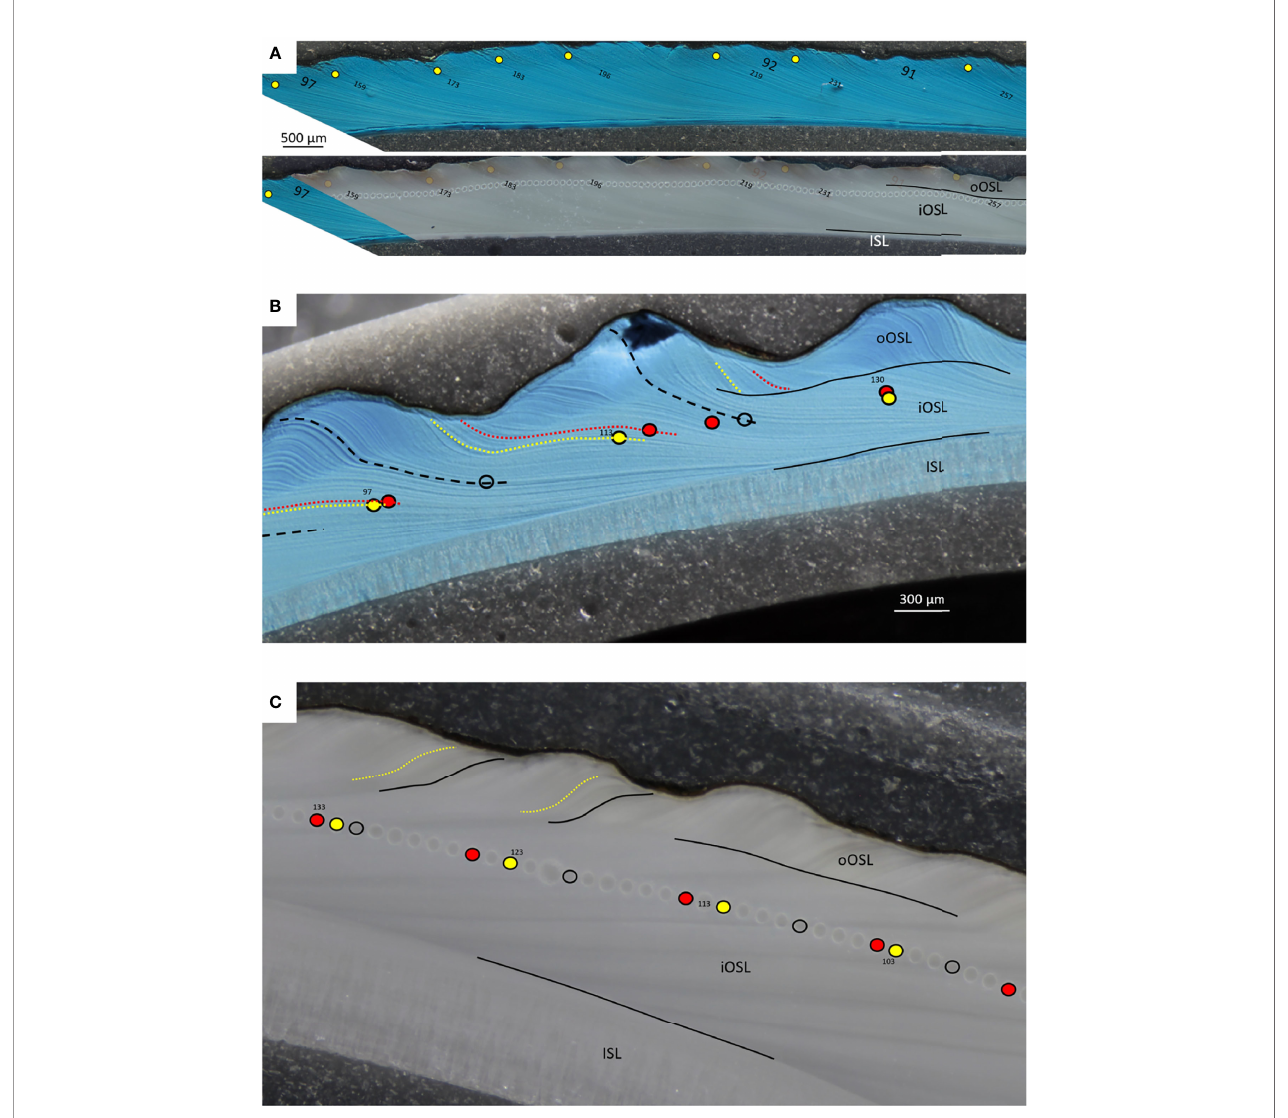
FIGURE 2 | Growth patterns in shells of Arctica islandica ( A , specimen MLZ-FBR36-A4L), Astarte elliptica ( B , MLZ-FBR36-A9L) and Astarte borealis ( C , MLZ- FBR06-A1L). ( A, upper panel + B ) = sectoral dark fi eld illumination; ( A, lower panel and C ) = bright fi eld illumination (with partly numbered LA-ICP-MS spots). Yellow circles and yellow dotted lines indicate seasonal magnesium peaks, red circles (LA-ICP-MS spots) and lines stand for manganese peaks, and black open circles in Astarte spp. denote Mn minima. Bold numbers in A = calendar years (e.g., “ 97 ” = 1997). In A. islandica , only one annual growth line is developed which forms in late fall and is associated with the seasonal Mg peak. In Mutvei-stained sections ( A upper panel), the annual growth lines were often dif fi cult distinguish from disturbance lines. In such cases, comparison with polished cross-sections ( A lower panel) was a great help, because distinct brown annual bands were occasionally developed with the Mg maxima occurring in their center. In Astarte spp., two annual growth lines can be distinguished which delimit a dark band (dark blue after immersion in Mutvei ’ s solution, B , and grey in polished sections, C ), i.e., a faint, Mg-rich line at the beginning and a distinct Mg-depleted line at the end. The dark band consisted of a series of very narrow intra-annual growth lines indicating slow winter growth. Intra-annual growth lines approached the outer shell surface at an increasingly steep angle toward the end of the growth band. With the beginning of the new growing season (lighter blue or grey in B , C , respectively), the angle became much shallower indicating fast shell growth. Faint black lines were used show the boundary between the different shell layers, i.e., the outer and inner portions of the outer shell layer (oOSL, iOSL) and inner shell layer (ISL). Note that the ISL in A. islandica is almost completely dissolved (A) , whereas both astartids show thick inner shell layers. In A. elliptica , the spiral rides of the outer shell sculpture (approx. one per year) are mirrored in the wavy boundary between the two sublayers of the OSL (B) , whereas the boundary between the oOSL and iOSL in A. borealis is much less wavy (C)